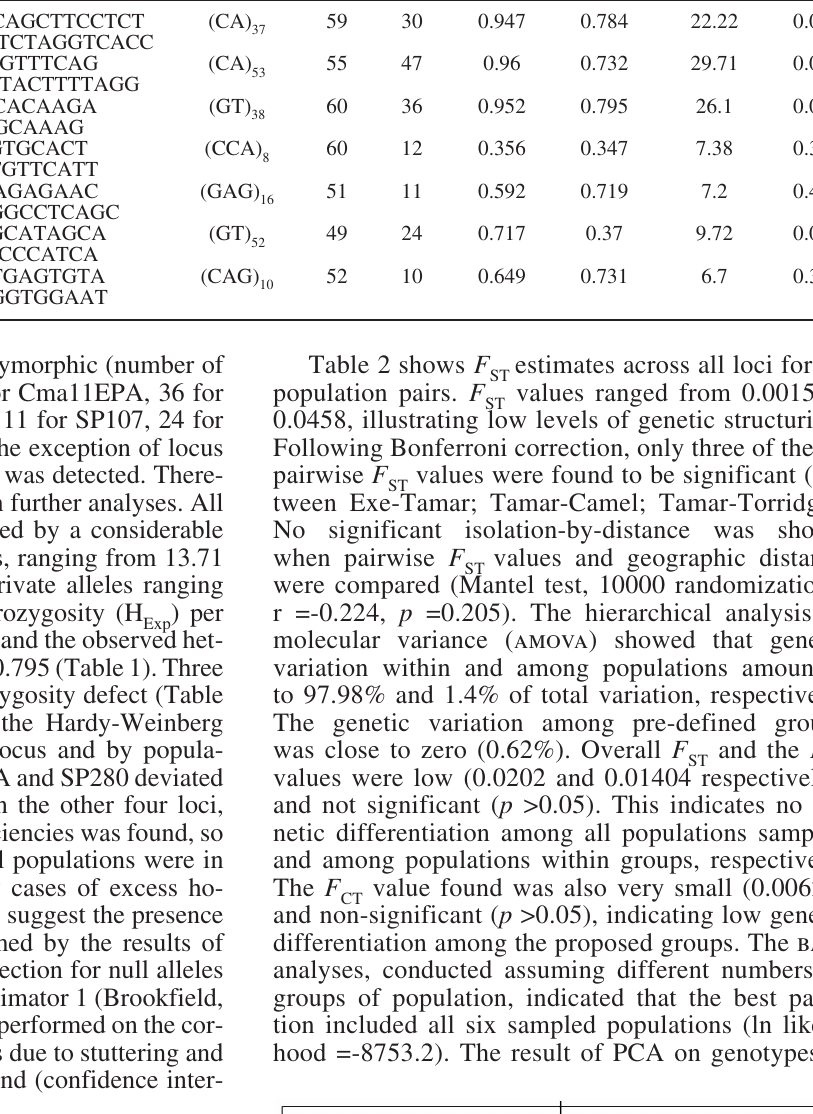
Table 1. – Main genetic variability measures by locus of Carcinus maenas . T (ºC), annealing temperature; N, number of alleles found per locus; H , expected heterozygosity; H , observed heterozygosity; Ar, allelic richness; p , Hardy-Weinberg test p -value. EXP OBS Locus Primer sequence 5’-3’